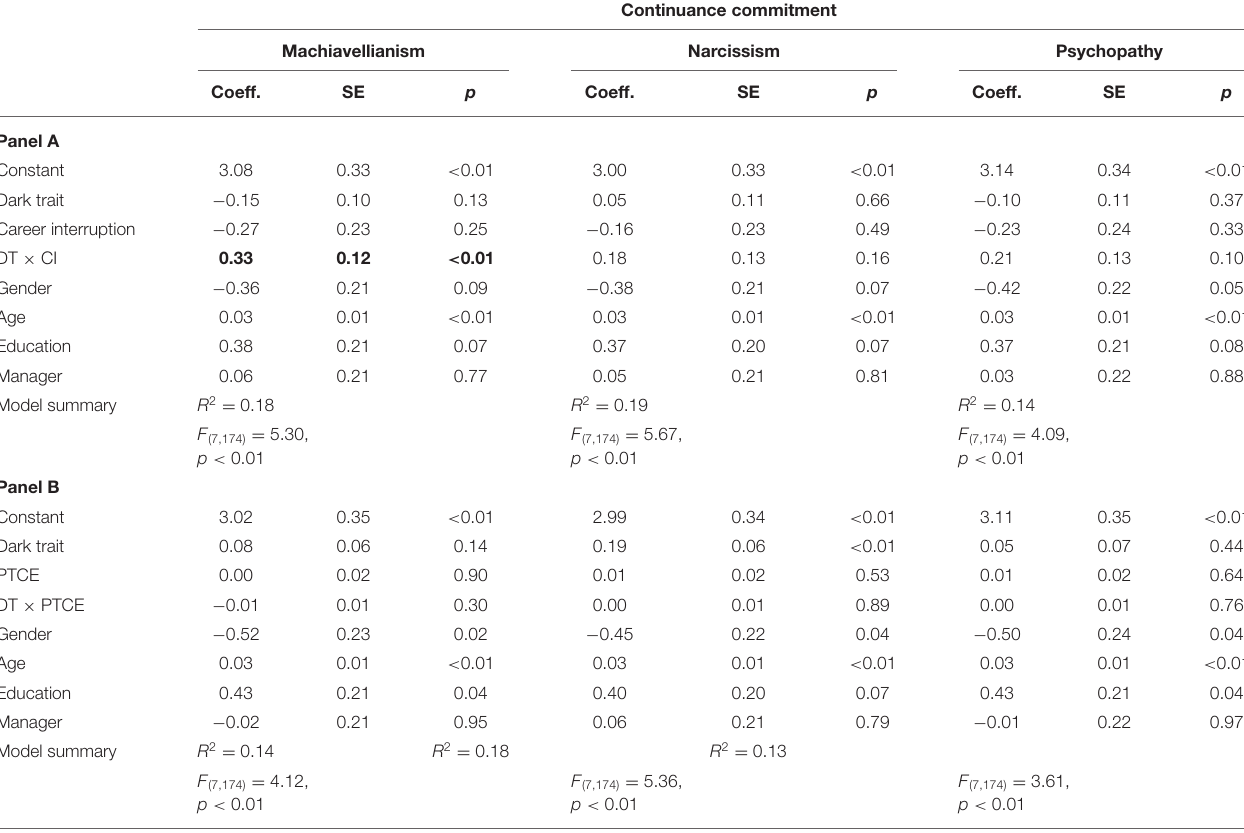
TABLE 3 | Multiple regression coefficients and model estimates predicting continuance